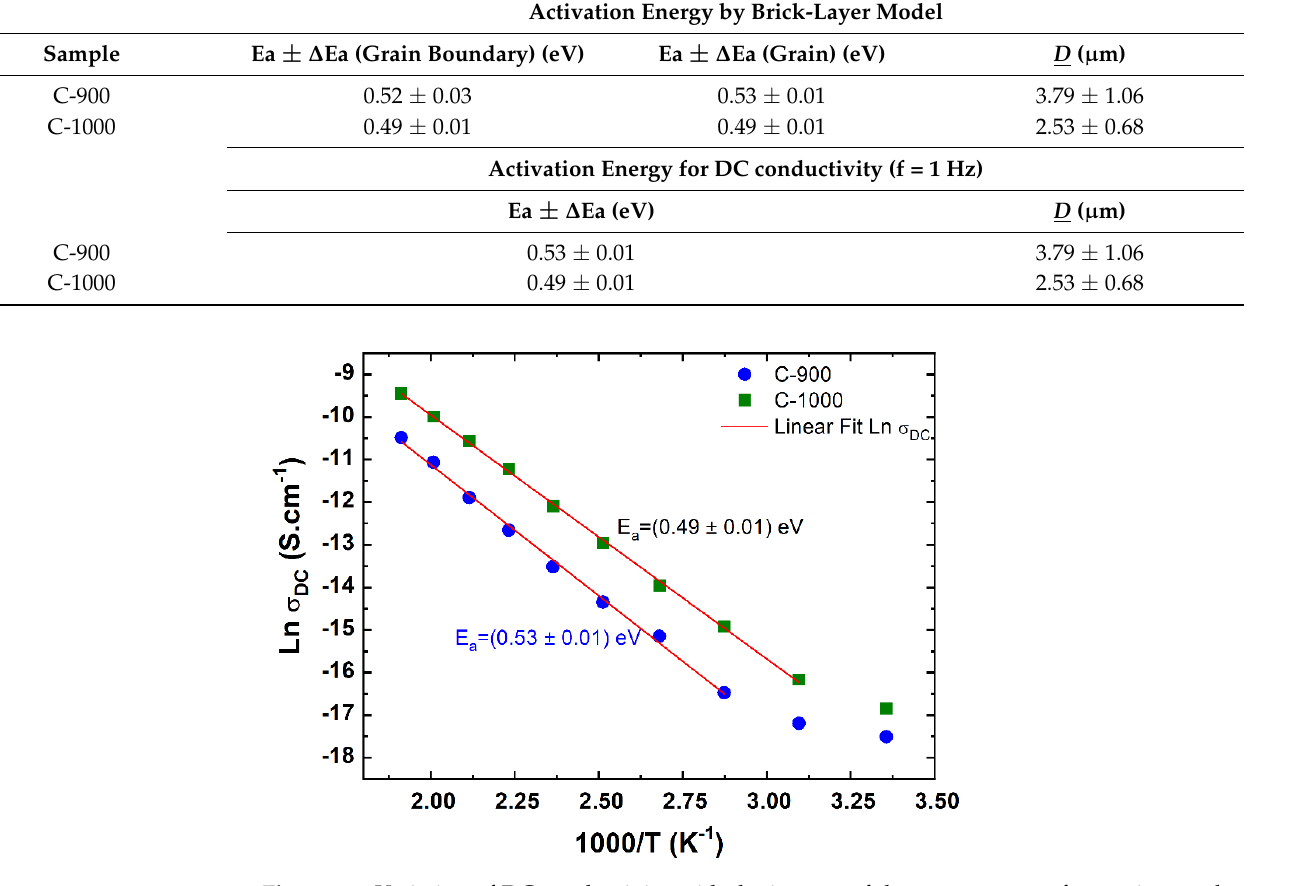
Figure 10. Variation of DC conductivity with the inverse of the temperature of ceramic samples, C- 900 and C-1000.